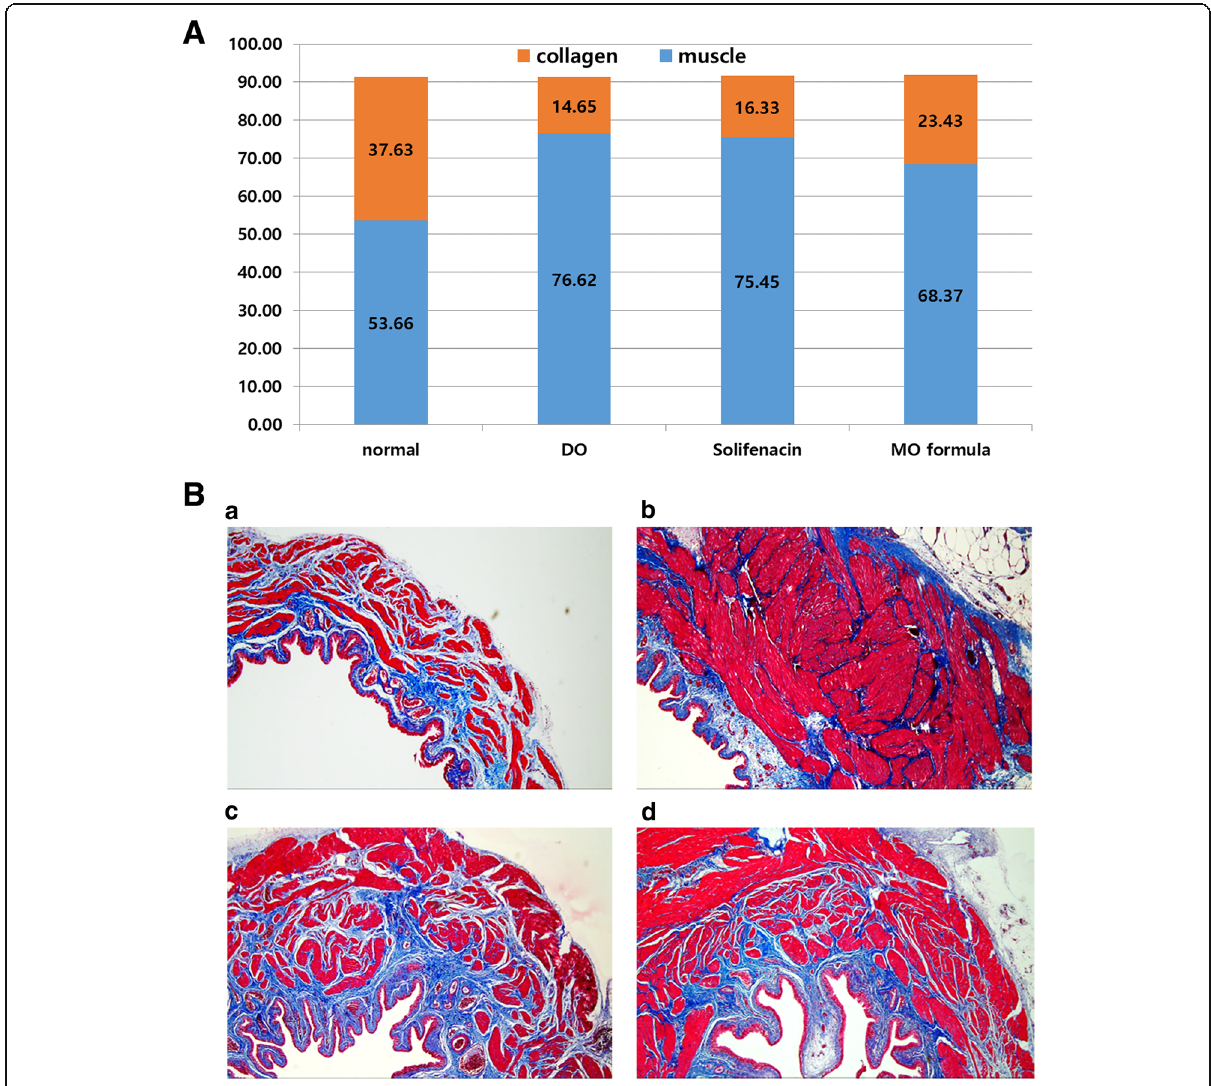
Fig. 7 Microscopic Changes in Rat Bladder. a Muscle-to-Collagen ratio. b Histology on Masson-Trichrome stain. Control. DO. Solifenacin. MO